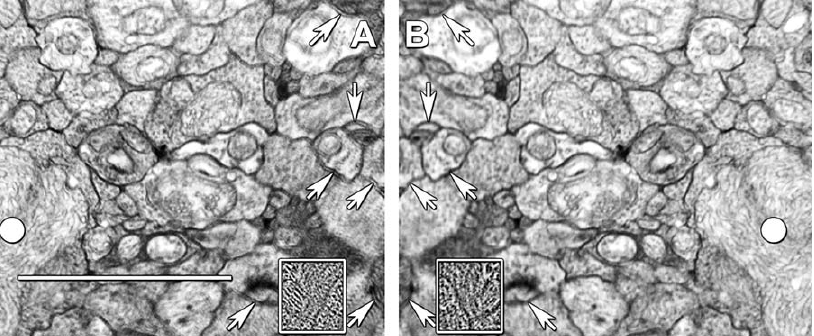
Figure 5. Recovery of Distortion Errors in Tile Overlaps with ir-fft and ir-grid-refine (A and B) are mirror images of the transparent overlays of fully overlapping regions of two tiles, both with best alignment centers on a large mitochondrion (white spot). (A) was auto-registered by ir-translate and many membranes appear as double images (arrows) due to nonlinear image distortions between the image pairs. (B) was registered with ir-grid-refine yielding improved membrane definition, even at very low magnification (resolution is about 5 nm/pixel, which accounts for the blurring). This is a worst-case scenario. With higher resolutions (more pixels) recovery is even more effective. The inset panels are high- pass 3 3 3-pixel filtered patches of the same region, showing severe moire´ defects in (A). Scale ¼ 2 l m.